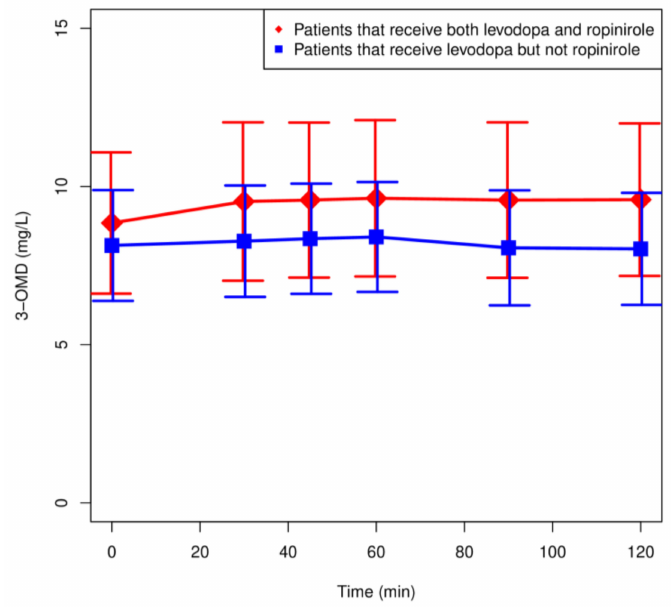
Figure 3. Plasma concentration: time profiles (mean values ± SEM) for 3-OMD of patients adminis- trating both levodopa and ropinirole ( n = 13) and patients administrating levodopa but no ropinirole ( n = 14).